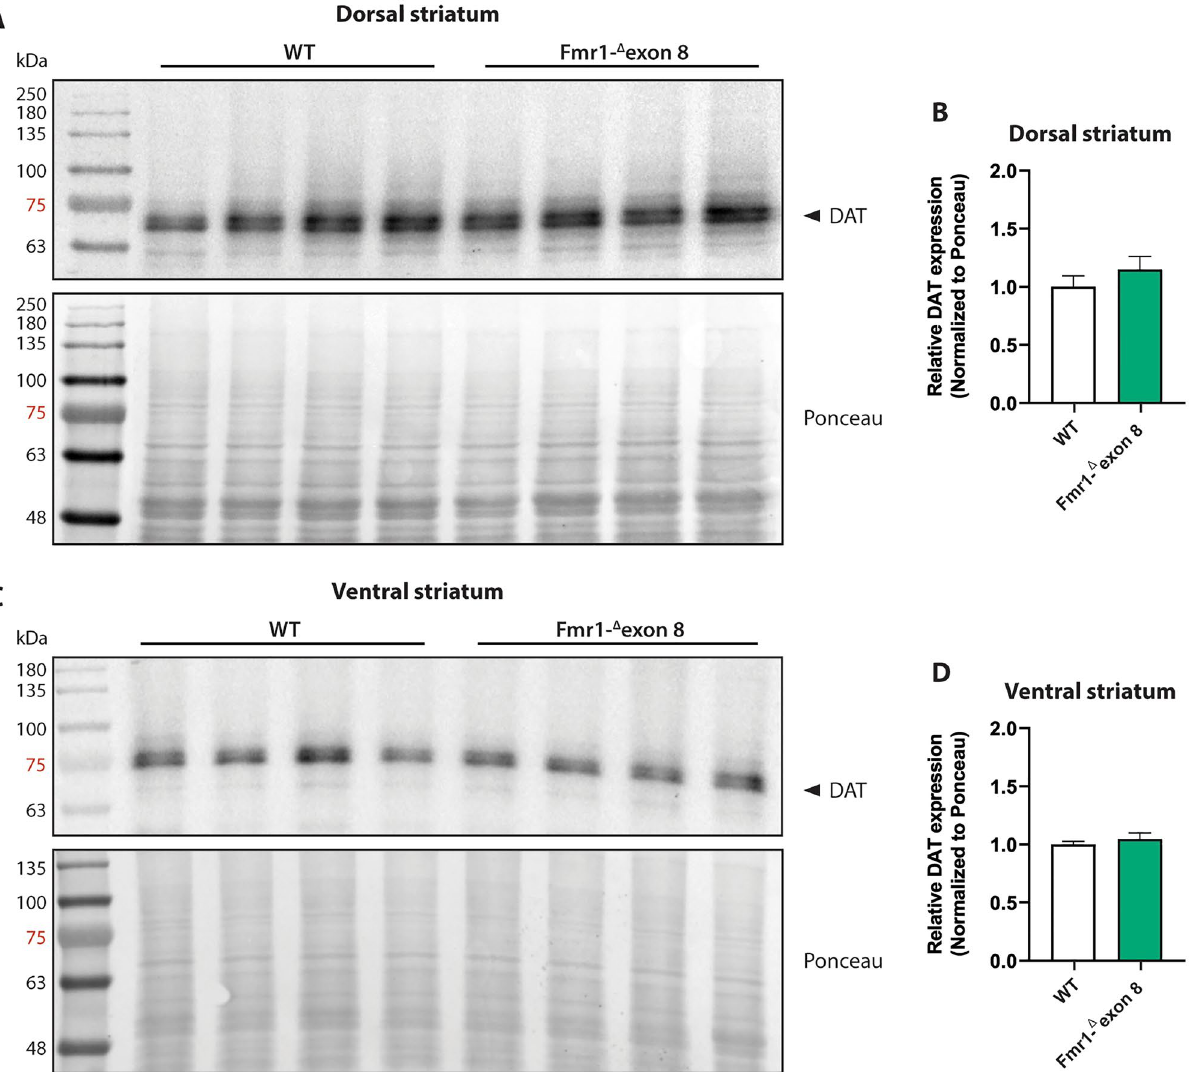
Figure 7. Western blot analysis. Representative western blot images of DAT in the dorsal ( A ) and ventral ( C ) striatum lysates from adult WT and Fmr1- Δ exon 8 rats. Quantitative analysis of DAT protein levels in the dorsal striatum ( B ) and ventral striatum ( D ) from adult WT and Fmr1- Δ exon 8 rats (WT = 4; Fmr1- Δ exon 8 = 4). Densitometric values of Fmr1- Δ exon 8 rats were normalized on Ponceau staining and expressed as relative fold change on WT animals. Data represents means ± SEM (Student’s